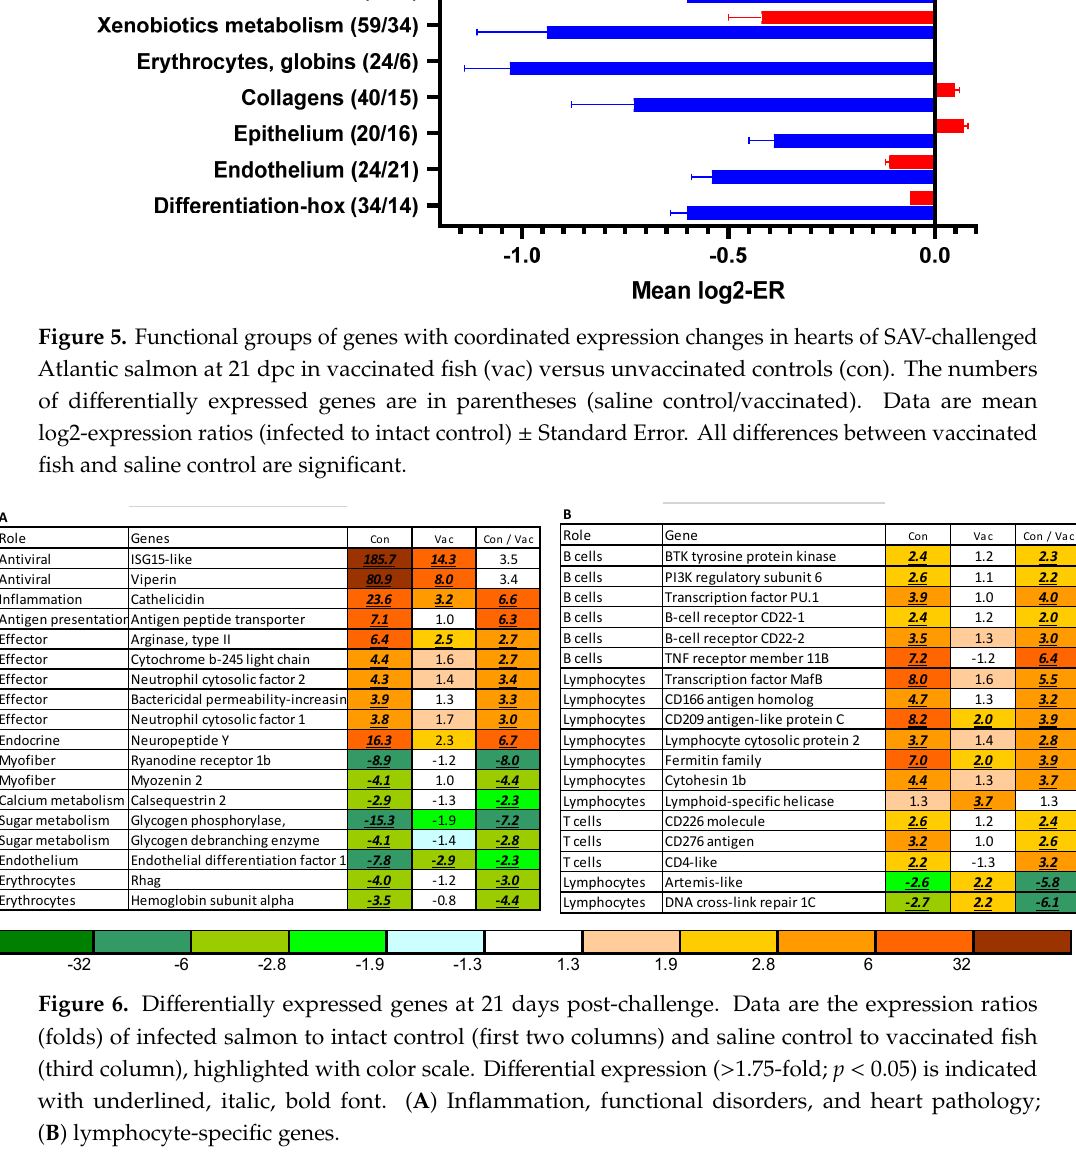
Figure 6. Differentially expressed genes at 21 days post-challenge. Data are the expression ratios (folds) of infected salmon to intact control (first two columns) and saline control to vaccinated fish (third column), highlighted with color scale. Differential expression (>1.75-fold; p < 0.05) is indicated with underlined, italic, bold font. ( A ) Inflammation, functional disorders, and heart pathology; ( B ) lymphocyte-specific genes.